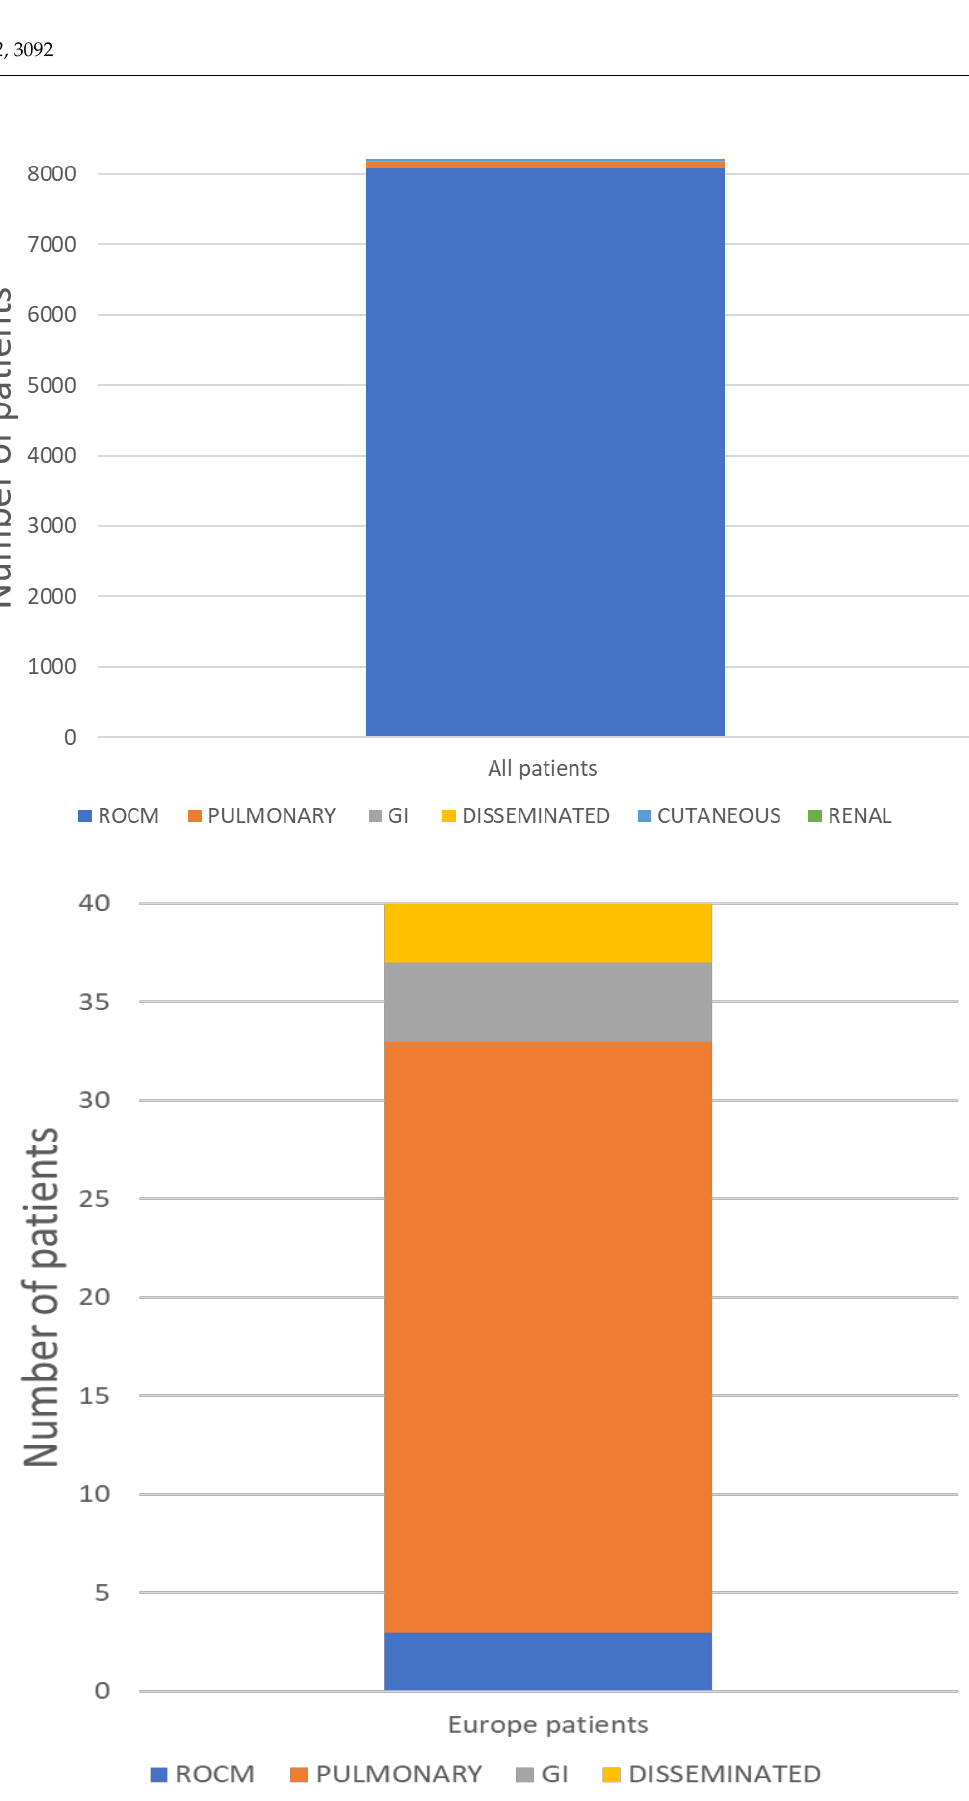
Figure 3. Clinical presentation of patients with CAM in total and in